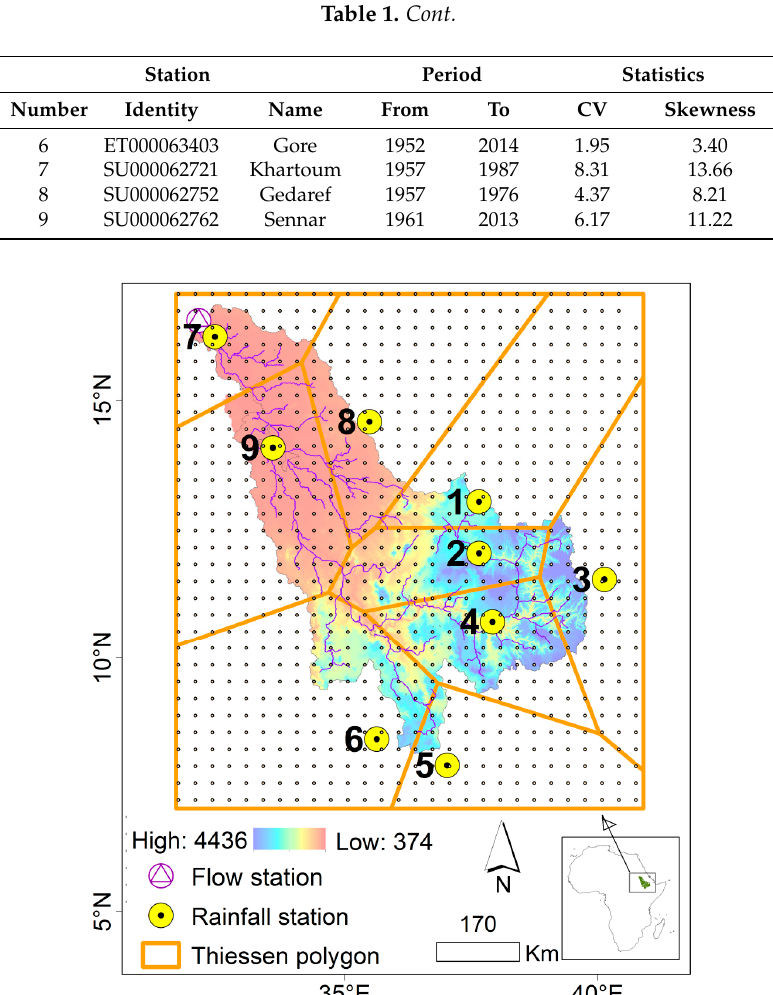
Figure 1. The Blue Nile Basin. The Digital Elevation Model (DEM) used as the background map was obtained online from the International Centre for Tropical Agriculture, CIAT-CSI SRTM website,